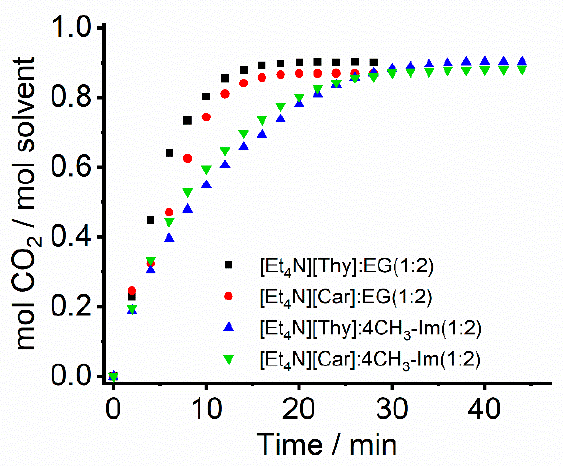
Figure 1. The CO 2 absorption by the DESs [Et 4 N] [Thy]:EG (1:2), [Et 4 N] [Car]:EG